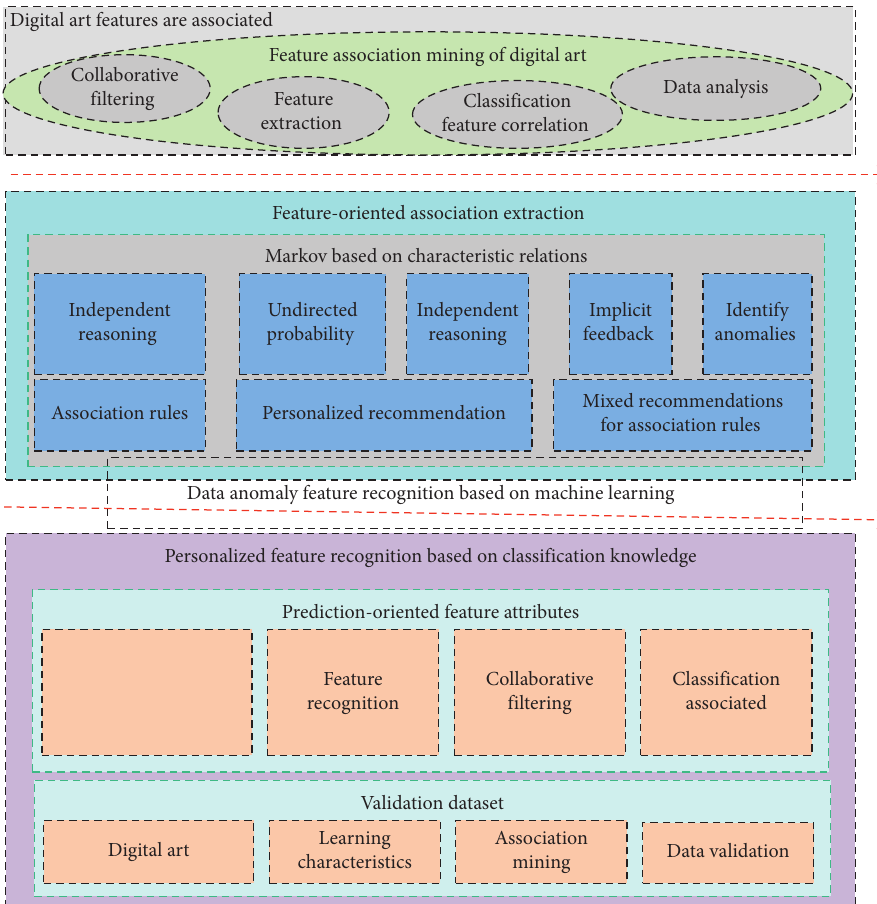
Figure 1: Research framework of feature association mining in digital art machine